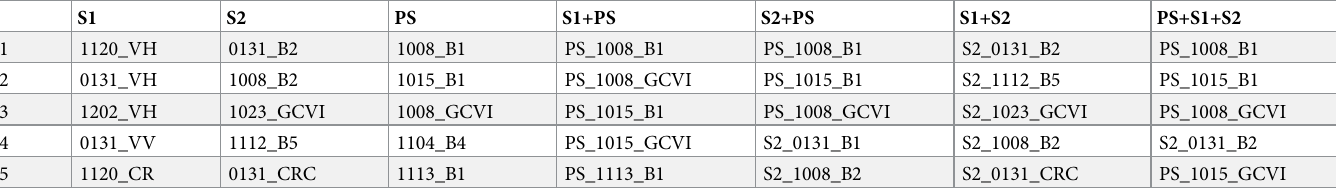
Table 5. Top five importance features for single and multiple sensor models for the full study period (Oct—Mar).